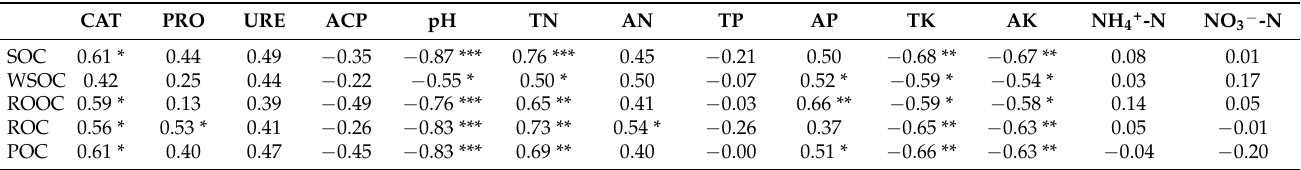
Table 3. Correlation coefficients of soil enzyme activity, organic carbon fractions, and chemical factors (0–10